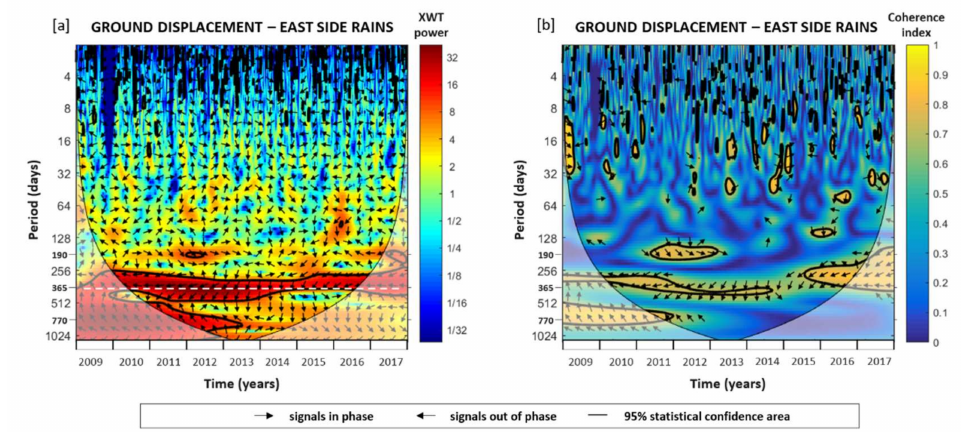
Figure 9. ( a ) Cross wavelet transform (XWT) and ( b ) wavelet transform coherence (WTC) between CODI CGPS data and rainfall data at Volano station. The thick black contour designates the 95% significance level against red noise, while the black contoured shading is the cone of influence where edge e ff ects occur. White dashed line indicates the result of cross-correlation with respect to the annual periodicity of the two